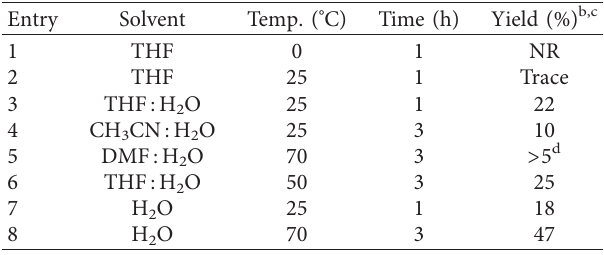
Figure 1: Bioactive compounds with phenol moiety. Table 1: Solvent study: hydroxylation of phenylboronic acid a